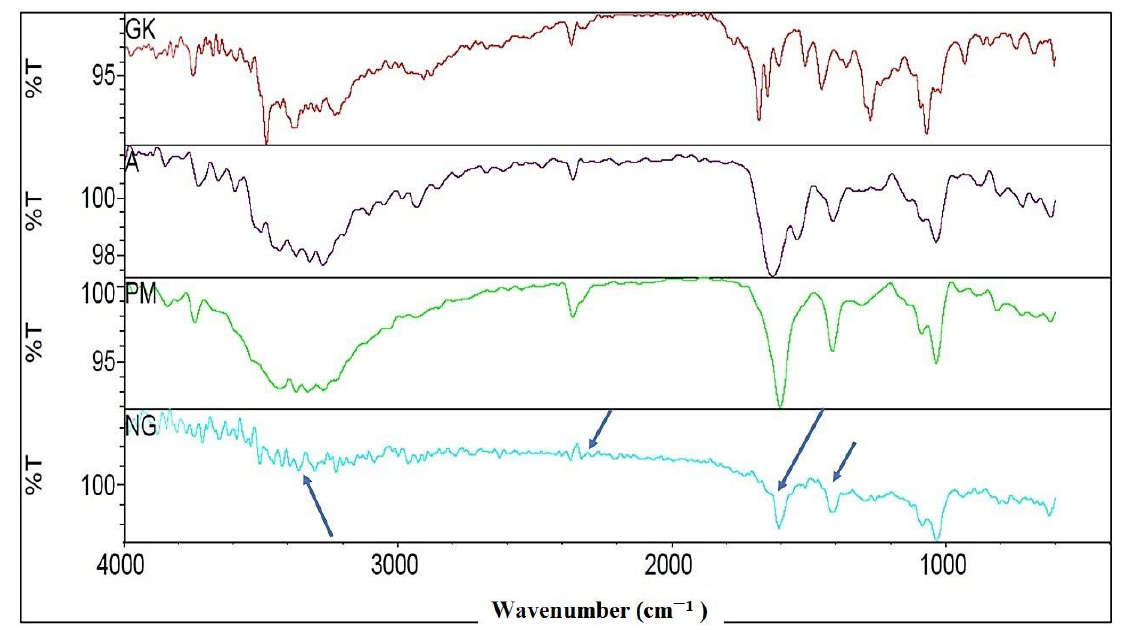
Figure 1. FTIR of Ginkgo biloba ginkgo extract (GK), alginate (A), physical mixture of GK and A (PM), and nanocomplex gel (NG).